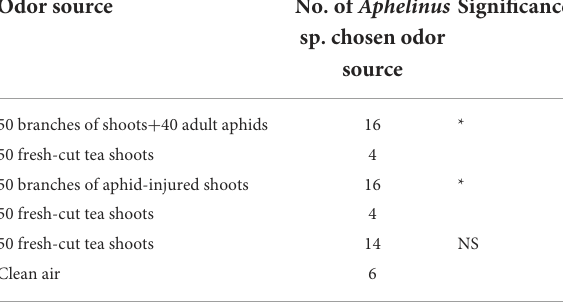
TABLE 5 Number of Aphelinus sp. attracted to tea shoot–aphid complexes or aphid-injured shoots vs. fresh-cut tea shoots plus fresh-cut tea shoots vs. clean